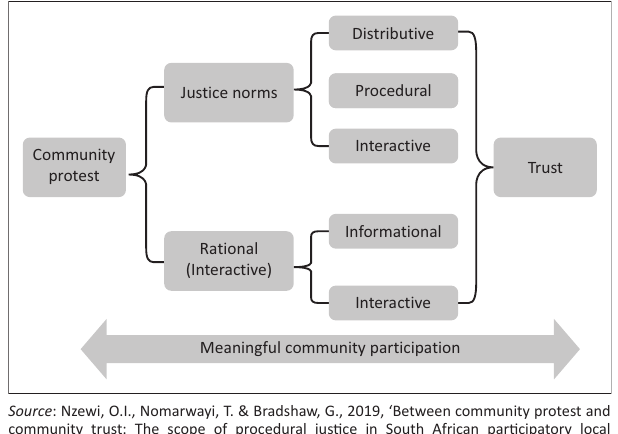
FIGURE 1: A conceptual framework for meaningful community